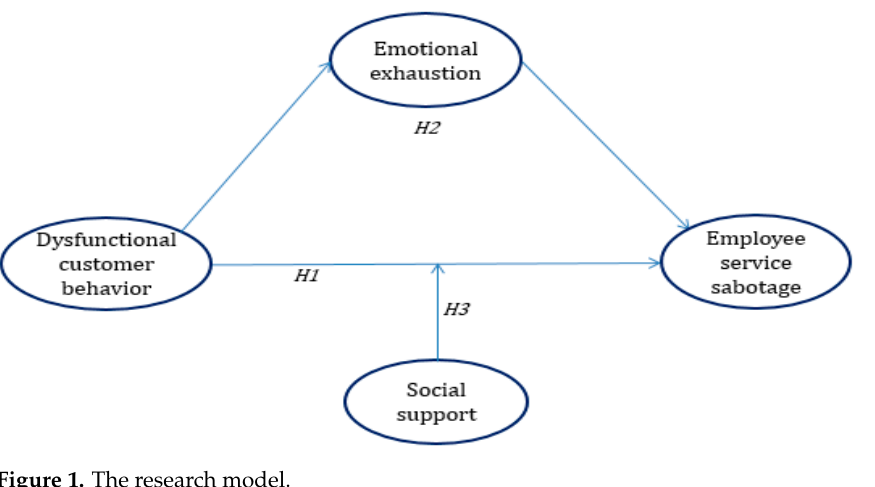
Figure 1. The research model.